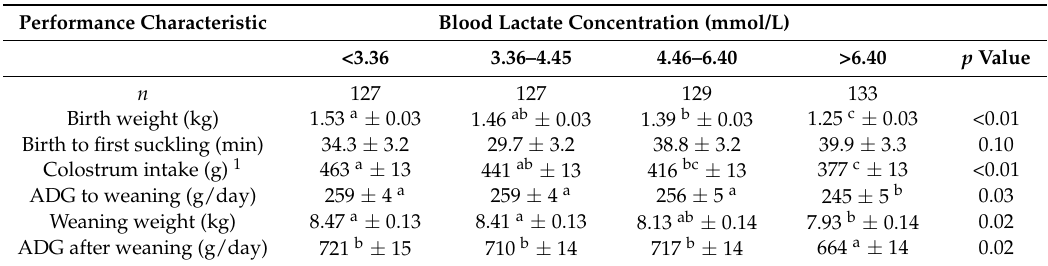
Table 1. Relationship between degree of asphyxia and neonatal performance to 10 weeks of